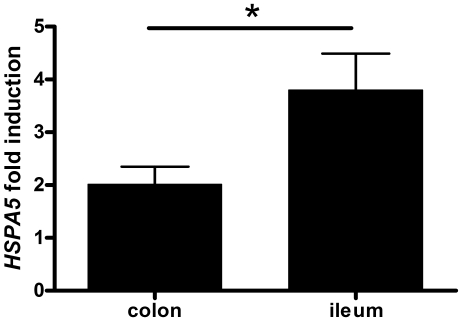
Tunicamycin induces ER stress in mucosal samples of healthy controls.Stimulation of paired colonic and ileal samples of five healthy controls with the ER stress inducer tunicamycin revealed an increased expression of HSPA5 mRNA in both colonic and ileal tissue, with a more pronounced induction in the ileal mucosa (*P = 0.048). Bars represent the fold induction of HSPA5 in treated samples relative to untreated samples.